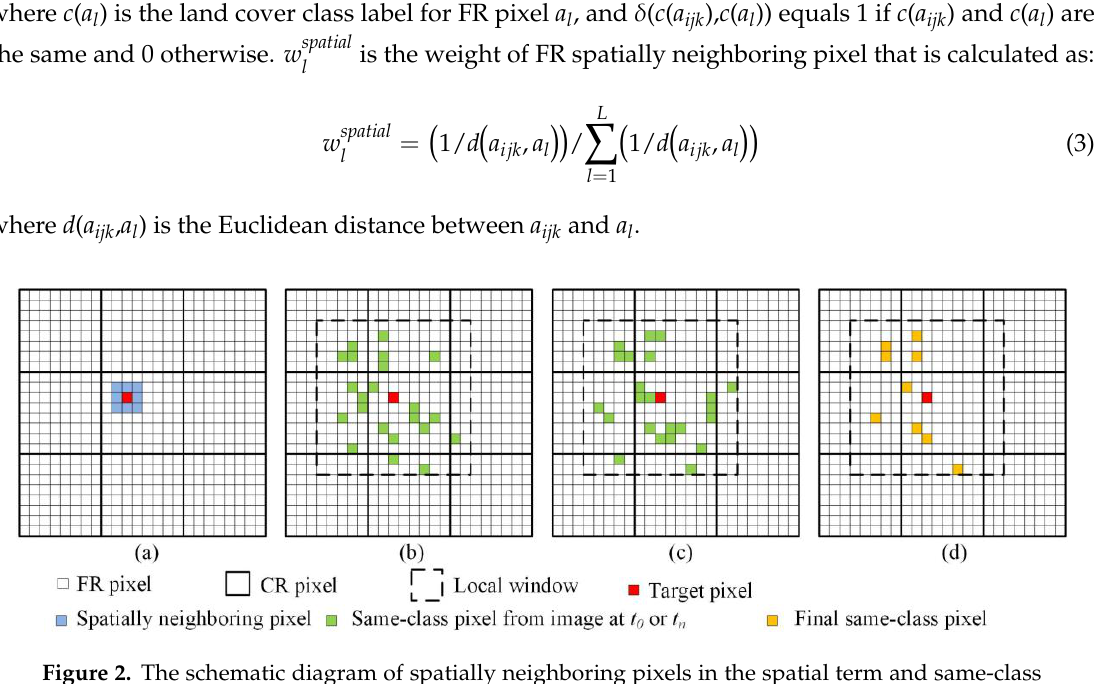
Figure 2. The schematic diagram of spatially neighboring pixels in the spatial term and same-class pixels in the ancillary data term. ( a ) Spatially neighboring fine spatial resolution (FR) pixels in the spatial term. ( b ) Same-class FR pixels selected from FR image at t 0 in the ancillary data term; ( c ) same-class FR pixels selected from FR image at t n in the ancillary data term; ( d ) final same-class FR pixels used in the ancillary data term. The FR pixels as same-class pixels from images at t 0 and t n in ( b , c ) are randomly selected in Figure 2.